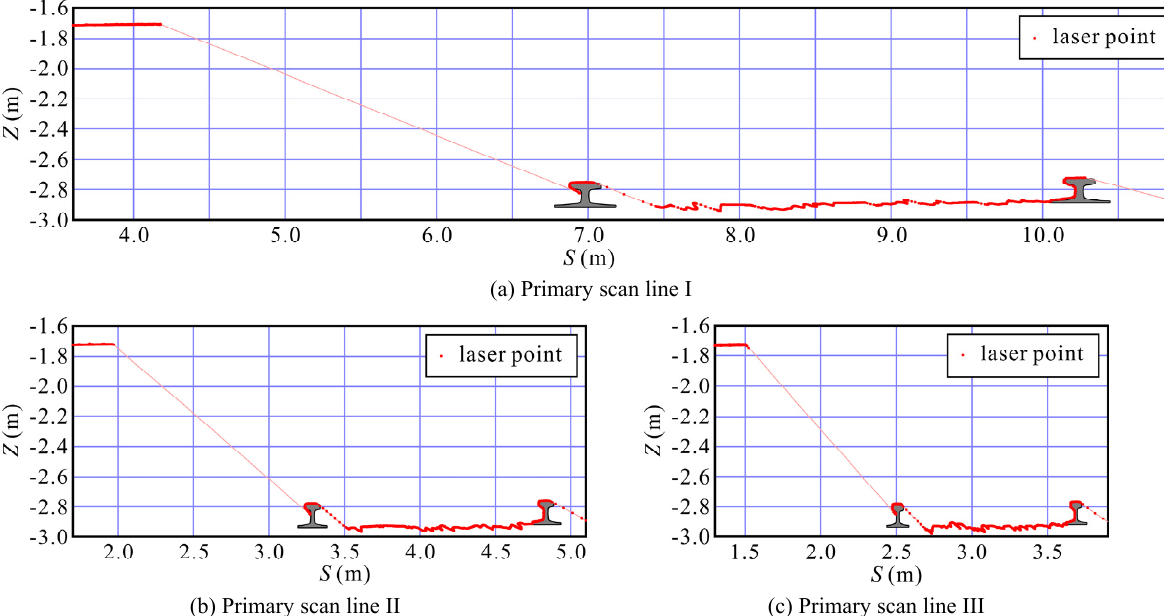
Figure 11 and those of the primary scan line C are shown in Figure 12. S in Figure 11 and Figure 12 means a horizontal distance from the scanner, while Z in those figures means a vertical coordinate where the origin of the vertical coordinate is the centre of the scanning. Figure 11 and Figure 12 indicate that the edges of the platform and the tops and sides of the two rails would be able to be detected from the acquired point data. However the horizontal distances S of the edges of the platform and the tops and sides of the two rails vary according to the direction of a primary scan line.